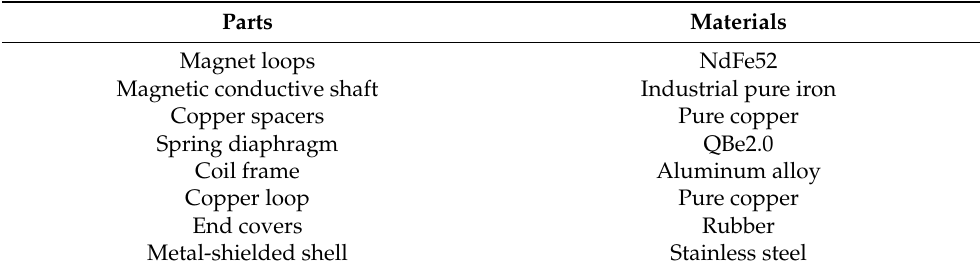
Table 1. Materials used in dual-magnet velocity